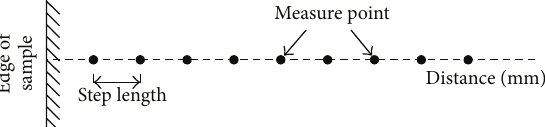
Figure 2: Distribution of measuring locations of HV.